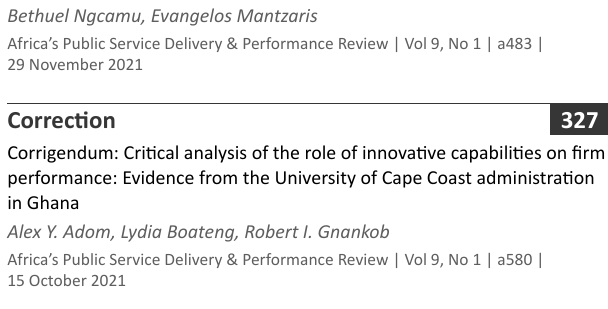
Erratum: Public sector reforms and national development: A situational analysis of post-independent